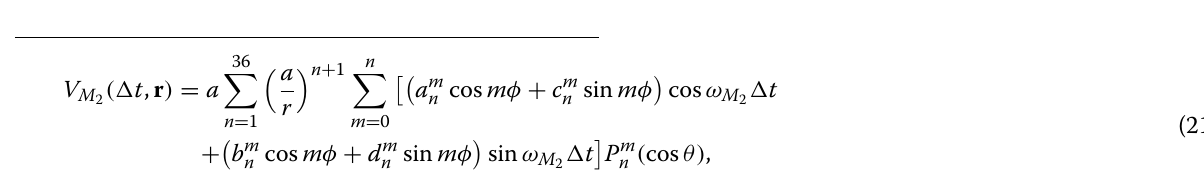
respect to local time during vernal equinox in the top four maps, and variation with respect to season in the bottom four maps. As the basis functions for the iono- sphere in CIY4 have QD symmetry, the QD latitudes of ± 55 ◦ and 0 ◦ are shown in red and blue, respectively. As expected, the top four maps show opposing streamlines mostly following QD lines of latitude and the two major solar-quiet (Sq) foci remaining mostly aligned along the same meridian during vernal equinox.